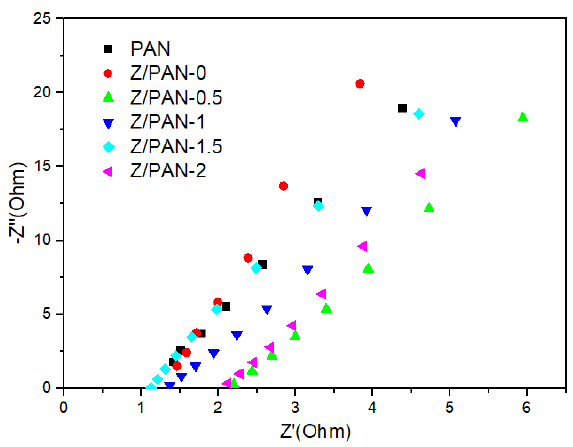
Figure 4. AC impedance spectra of the symmetric stainless-steel cells of different separators.